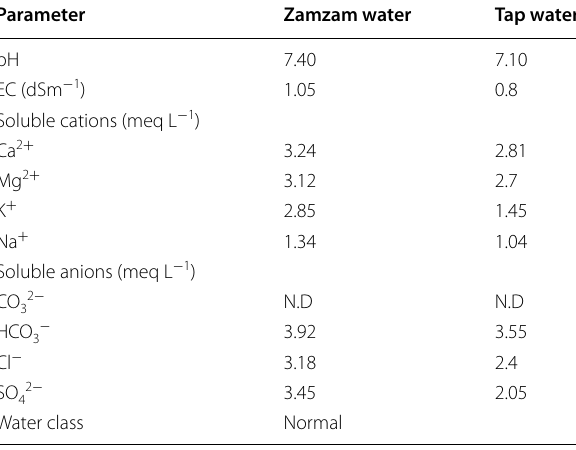
Table 3 Chemical analysis of two used water samples (Zamzam and tap)